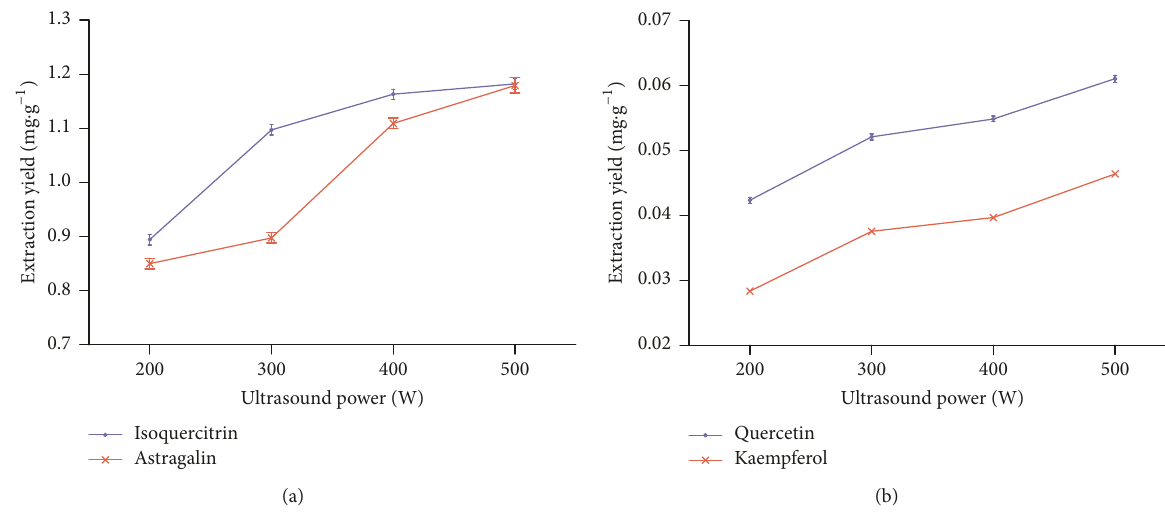
Figure 8: Effect of ultrasound power on extraction yields. Type of IL: [BMIM]BF 4 ; concentration: 0.5 mol ⋅ L −1 ; the particle size: 24 mesh (a) and 40 mesh (b); solid-liquid ratio: 1: 10g ⋅ mL −1 (a) and 1:20 g ⋅ mL −1 (b); ultrasound time: 20min (a) and 45 min (b); centrifugation speed: 5000 r ⋅ min −1 .